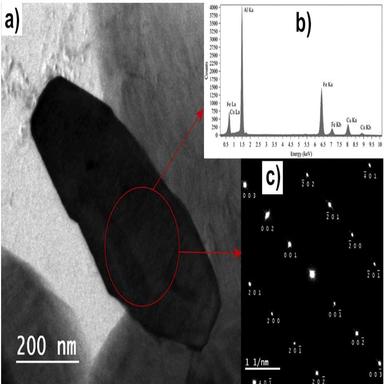
a) Bright field TEM image obtained at the interface between Al and the θ layer. The EDS analysis (b) and SAED pattern (c) were obtained at the encircled area, and confirmed the presence of Fe4Al13 phase.